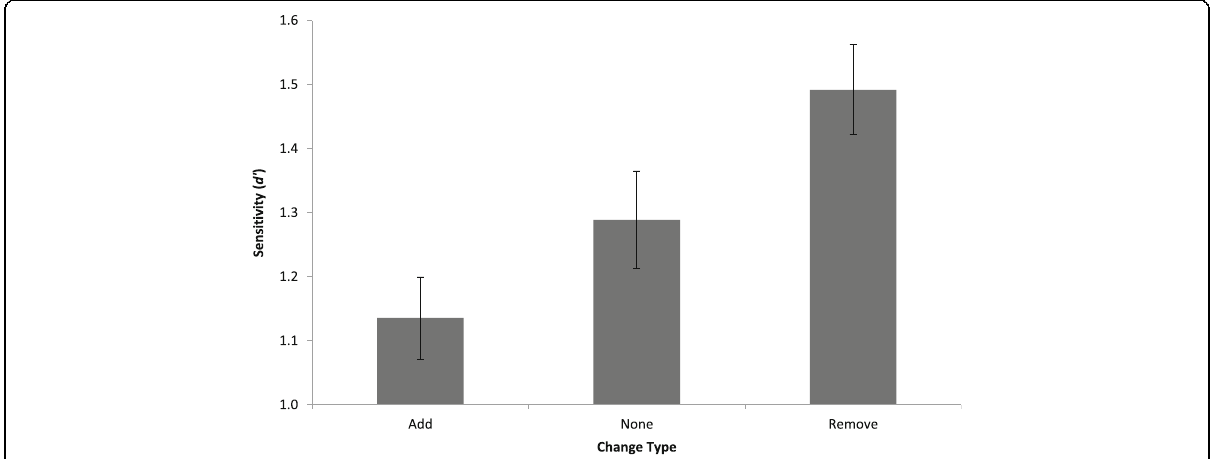
Fig. 4 Sensitivity in the cued recall task as a function of change type in the change discrimination task with SE bars